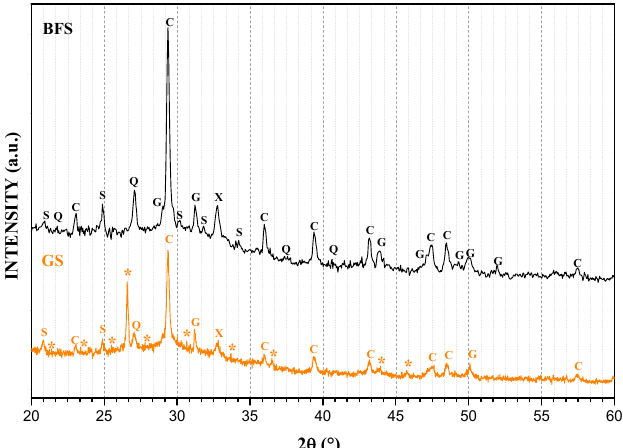
Figure 1. X-ray di ff raction (XRD) patterns of blast furnace slag (BFS) and GS. S = Calcium silicate, Q = Quartz, C = Calcite, G = Gehlenite, X = Magnesite, * = calcium aluminosilicate hydrated (CASH) and sodium aluminosilicate hydrated (NASH) type gels.